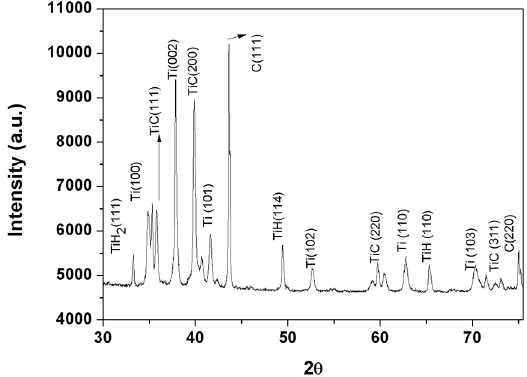
Figure 3. X-ray diffraction of diamond films grown on titanium substrates with 15000 ppm B/C.